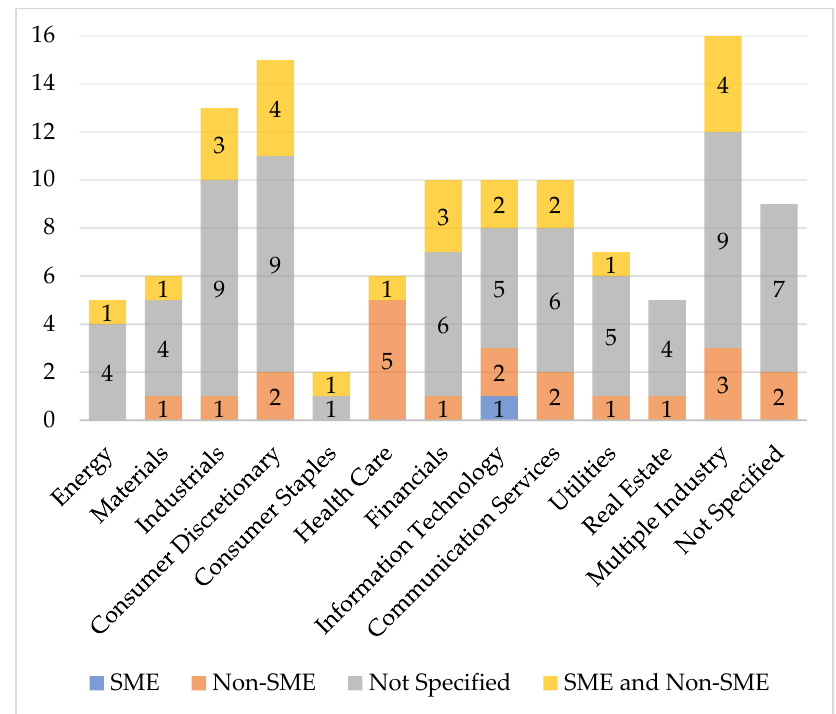
Figure 7 . Firm size based on MSCI industry classification